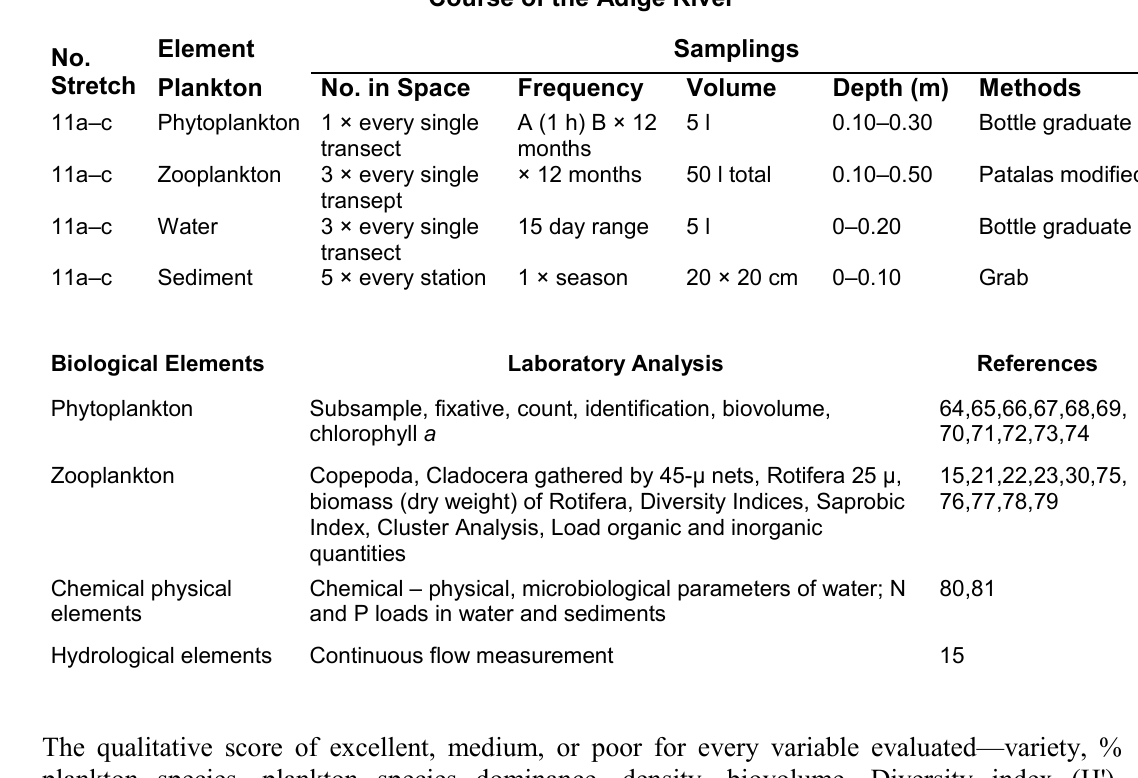
Sampling of the Biological, Physical - Chemical Elements in the